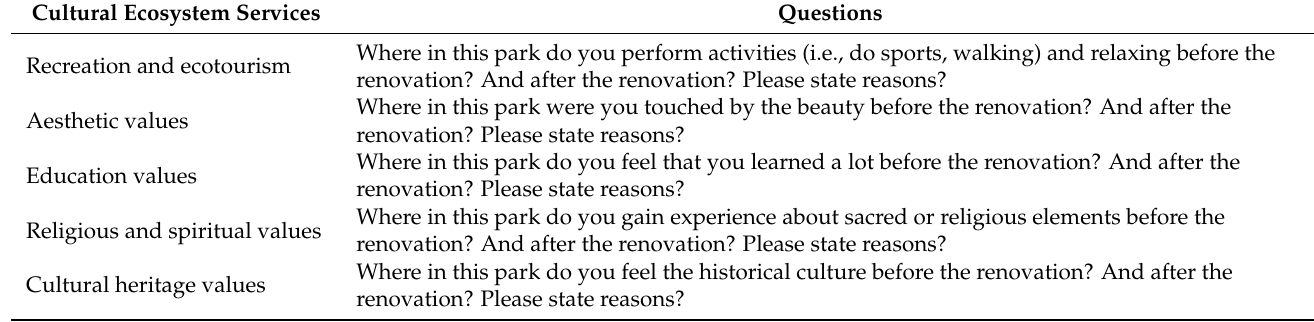
Table A1. Protocol of